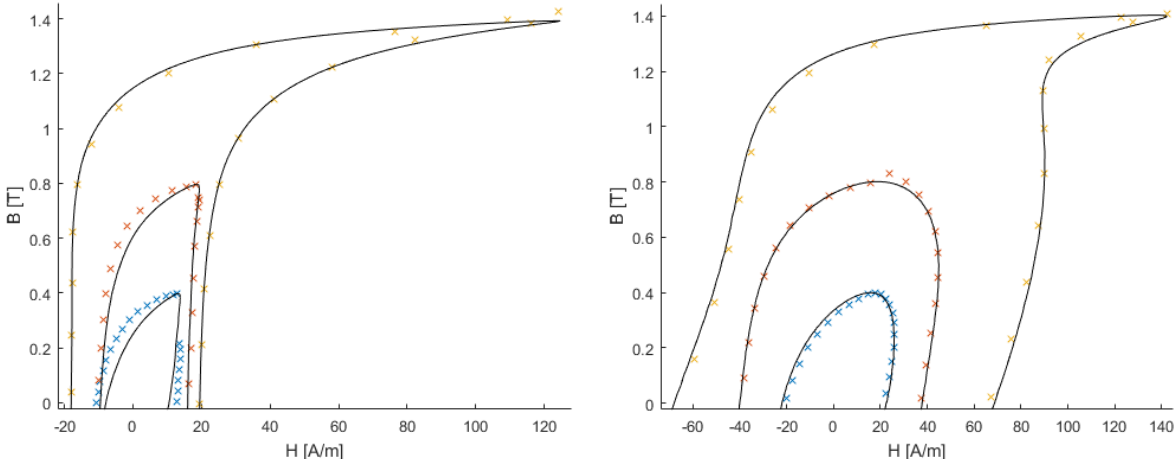
Figure 4. TEST 2: comparison between the simulated loops (colored cross markers) and the experimental ones (black continuous lines) with amplitudes of 0.4, 0.8, and 1.4 T, at a frequency of 20 Hz ( left panel) and 400 Hz ( right panel).